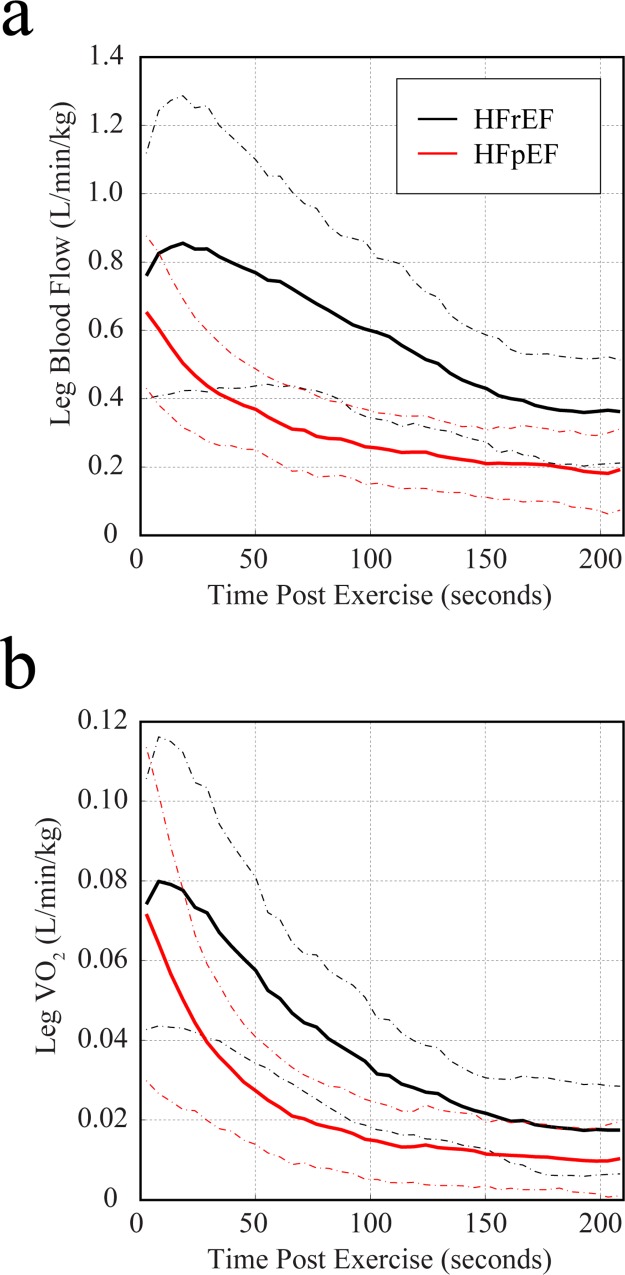
Group average recovery kinetics for blood flow and oxygen consumption (normalized to muscle mass).Average time course data for muscle blood flow (a) and muscle VO2 (b) are shown for HFrEF (black) and HFpEF (red) groups, with normalization of values in each subject to their quadriceps muscle mass. The dashed lines show one standard deviation around the mean.